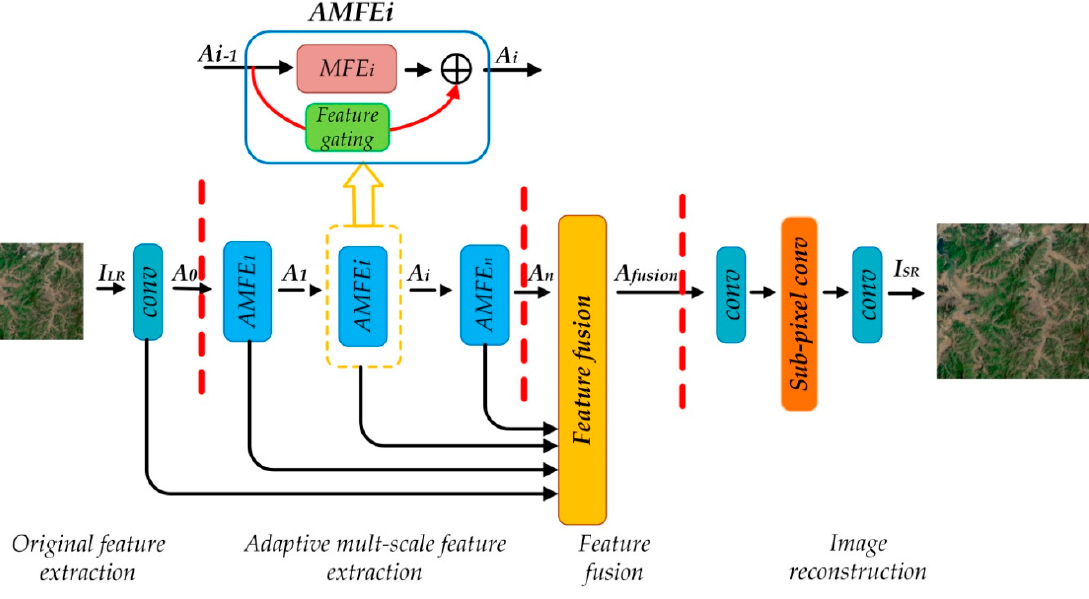
Figure 1. Network architecture of the proposed method.